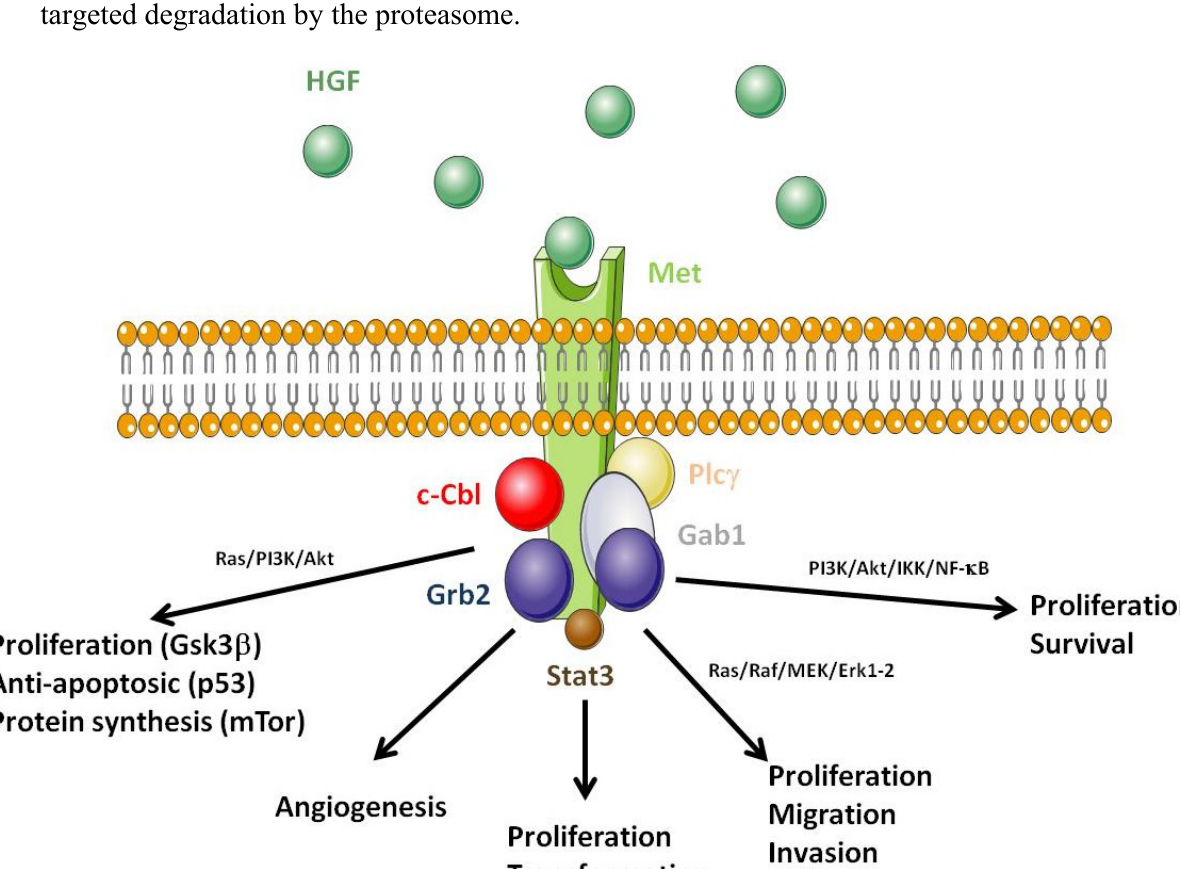
Figure 1. Consequences of the disruption of hepatocyte growth factor (HGF)/Met function. HGF (green circles) binding to Met induces receptor dimerization; the Met kinase is then activated by auto-phosphorylation of tyrosine residues. Met activation induces the recruitment of proteins acting as adaptors for other downstream signalling